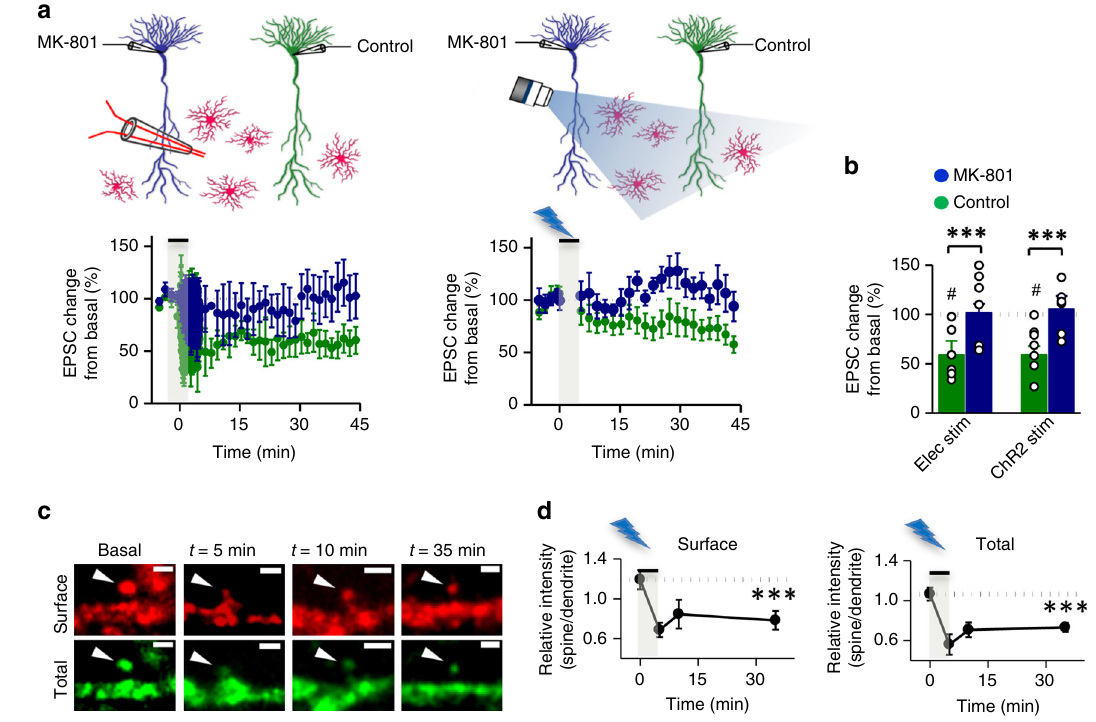
Fig. 5 NMDAR-dependent LTD induced by astrocytes is expressed postsynaptically. a (Top) Schematic representation showing the experimental design for LFS with electric stimulation (left) and ChR2-astrocyte photostimulation (right), from control (green) or MK-801- fi lled (1 mM, blue) neurons, in acute hippocampal slices. (Bottom) Relative EPSC changes from basal values versus time from the experiments represented on top ( n = 6 for electric stimulation, and n = 7 for ChR2-astrocyte stimulation). b Summary of results from the average change in EPSC 45 min after the onset of LFS protocol. No differences were observed by two-way ANOVA between electric and ChR2-astrocyte stimulation. A signi fi cant effect was found for MK-801 F (1, 22) = 14.64; P = 0.0009. Wilcoxon statistical test was used to analyze LTD expression with respect to baseline ( # P < 0.05). c Representative confocal images of dendritic spines from CA1 neurons expressing EGFP-GluA2 in organotypic hippocampal slices. Green channel represents total receptor expression (EGFP signal) and red signal represents surface expression (anti-GFP immunostaining under non-permeabilizing conditions). Images were acquired before (basal) and at different times after photostimulation. Scale bars, 1 μ m. d Quanti fi cation of spine/dendrite ratios for surface (left panel) or total (right panel) EGFP-GluA2 expression from neurons before and after photostimulation ( n t = 0 = 365; n t = 5 = 197; n t = 10 = 393; n t = 35 = 116 spines from n = 3 experiments). Time zero corresponds to the onset of the photostimulation protocol. Differences between groups were determined by Kruskal – Wallis test followed by Dunn ’ s test (*** P < 0.001). Data are presented as means ±